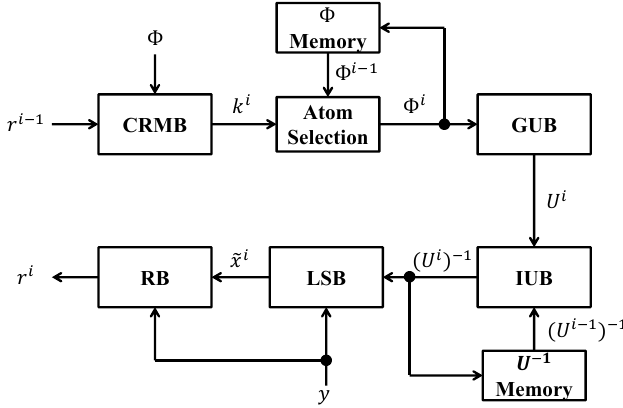
Figure 3. Simultaneous orthogonal matching pursuit (SOMP) structure with the proposed partitioned inversion.